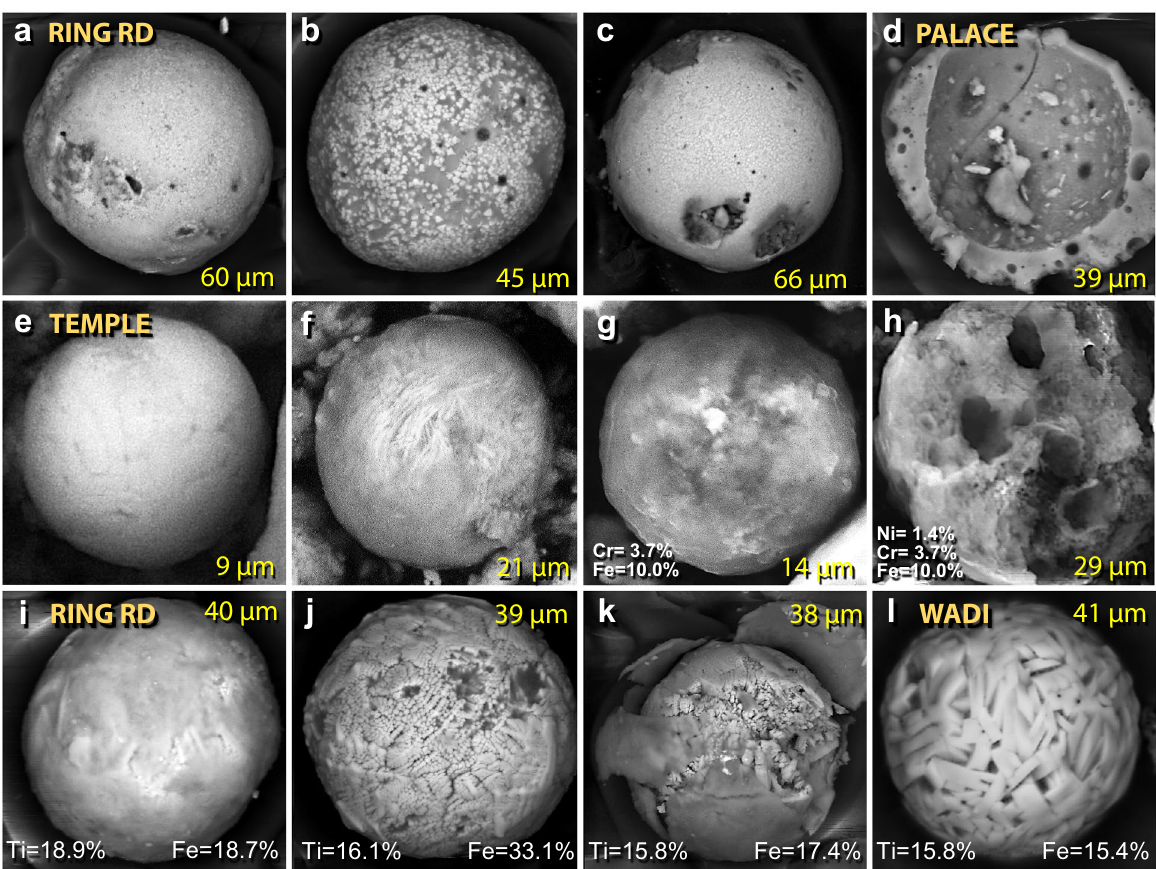
Figure 25. SEM images of mostly silica-rich spherules from TeH. ( a )–( d ) Representative spherules from the ring road on the lower tall. SEM images of iron-rich spherules. ( e )–( f ) Fe-rich spherules from the temple complex. ( g ) temple spherule containing ~ 3.7 wt.% Cr. ( h ) Broken, vesicular spherule from temple containing 1.4 wt.% Ni and 3.7 wt.% Cr. SEM images of titanium-rich spherules. Ti content of these ranges from 18.9